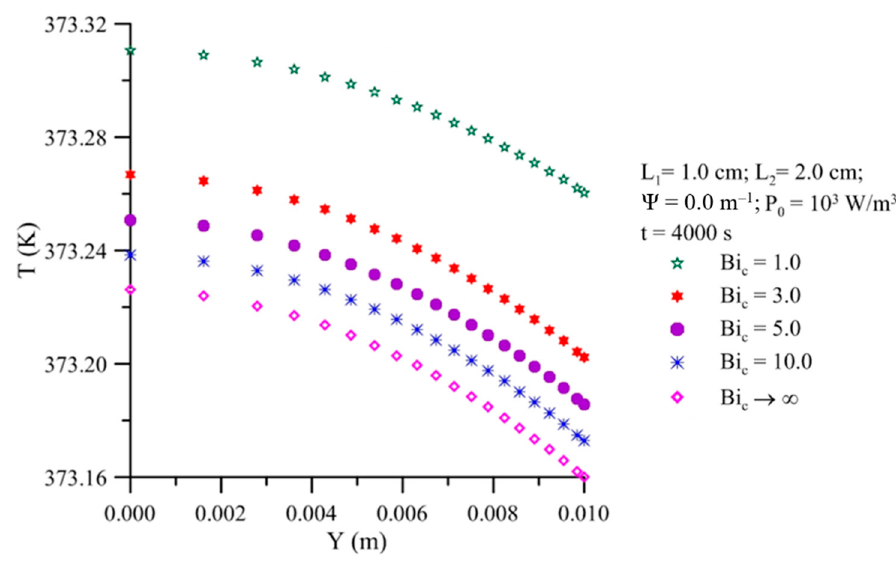
Figure 12. Temperature inside a prolate spheroidal solid with aspect ratio L 2 /L 1 = 2.0, different heat transfer Biot numbers and fixed microwave power density ( y -axis, z = 0, t = 4000 s).